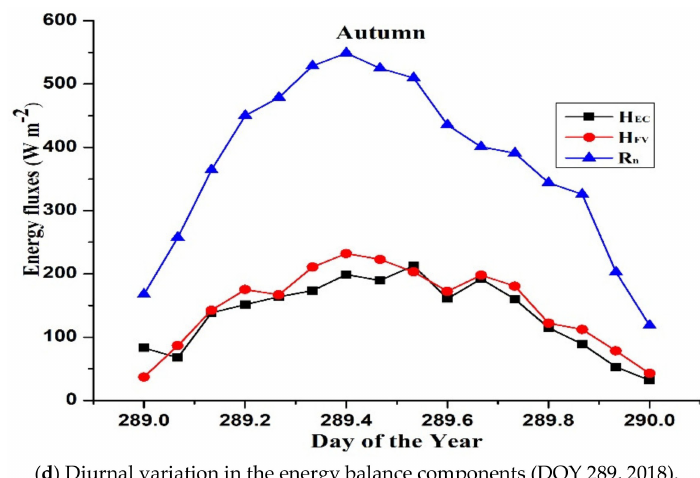
Figure 10. Diurnal variation in net radiation and sensible heat flux estimated by the FV, and EC methods during different climatic conditions ( a – d ), representing different seasons during